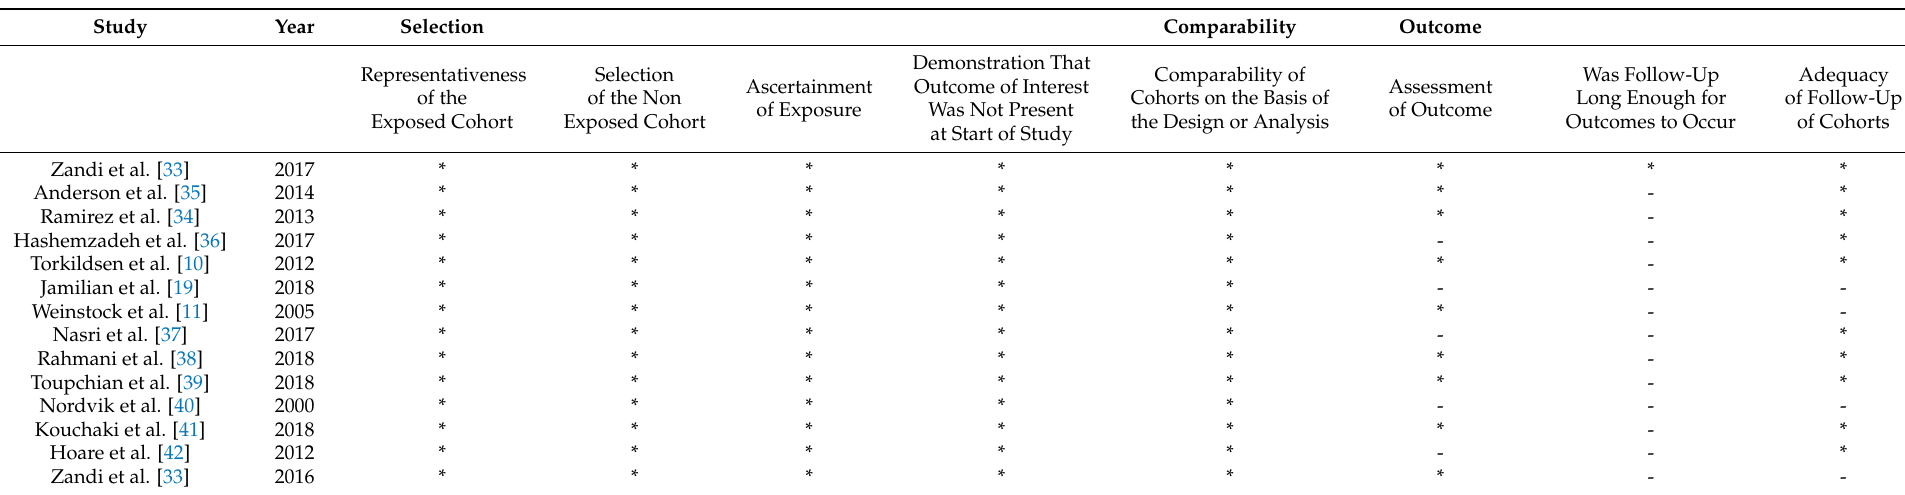
Table 2. Quality assessment of cohort